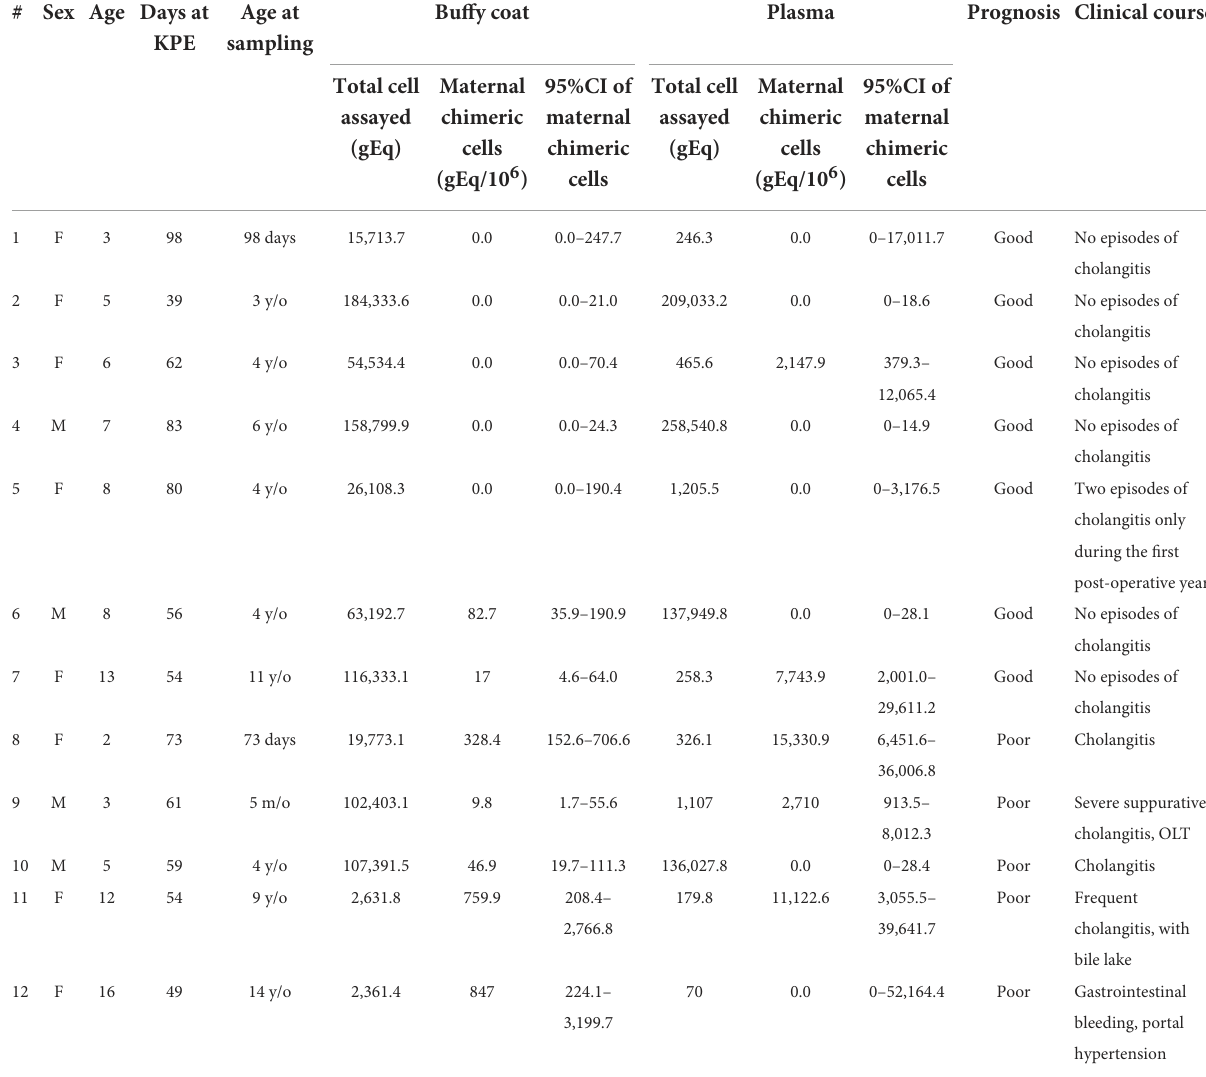
TABLE 1 Demographics, quantities of maternal chimeric DNA, and the prognosis of each patient. # Sex Age Days at Age KPE